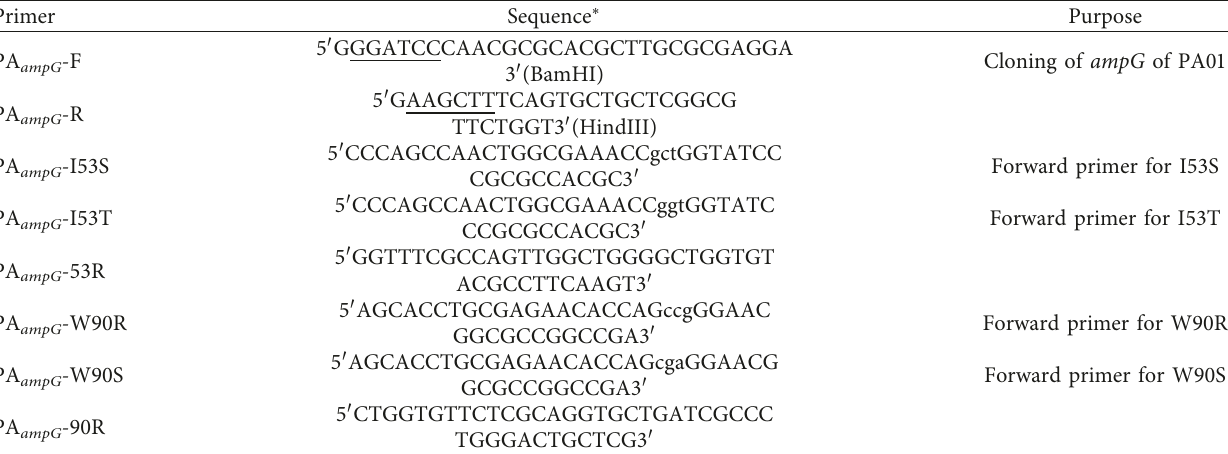
Table 2: Primers used in this work.